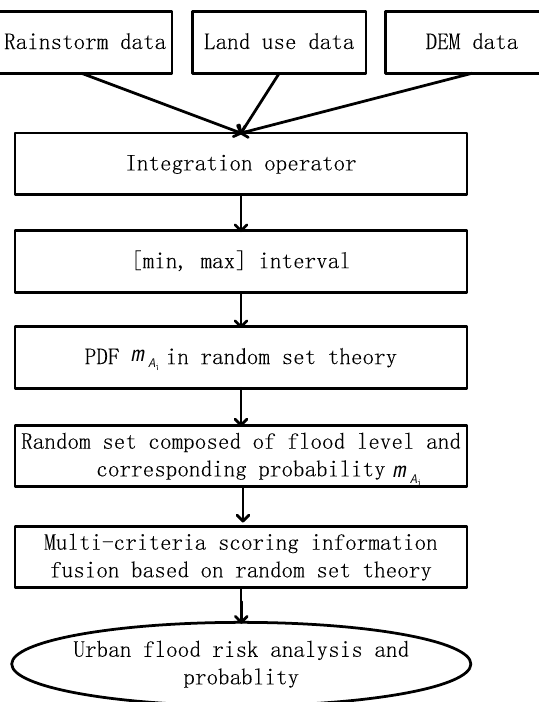
Figure 3.Flow chart in flood risk assessment based on multi- source information fusion and random set